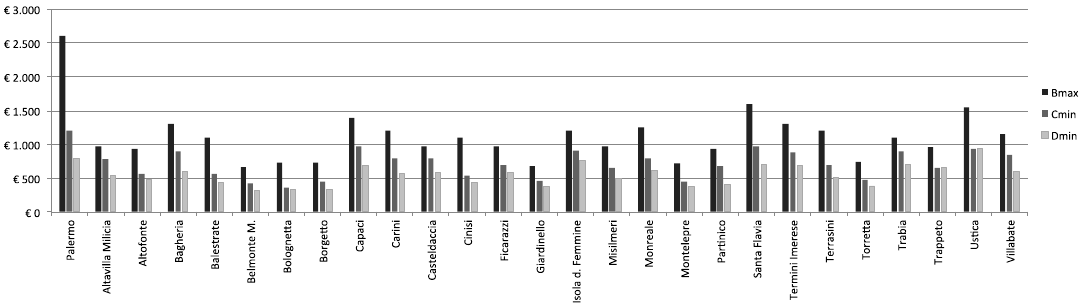
Figure 6. Purchase. Housing prices in euros/m 2 ( y -axis) in the municipalities of the NWA area (II semester 2016) (our elaboration on OMI data).